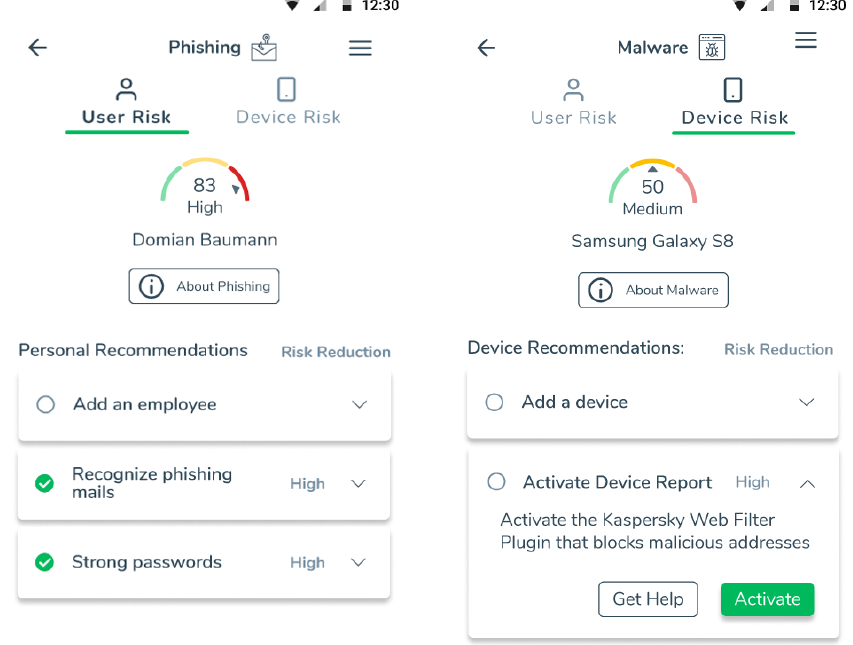
Figure 5. Phishing and malware recommendations shown to the user in the GEIGER user interface.